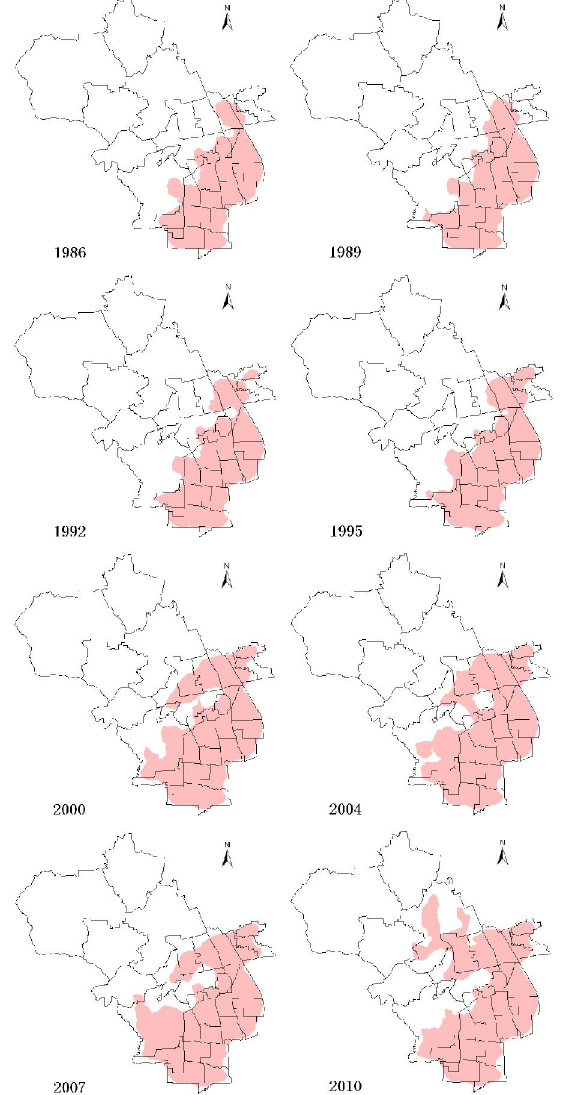
Figure. 6 Temporal-spatial variation of city range by Landsat TM between 1986 and 2010, Haidian District